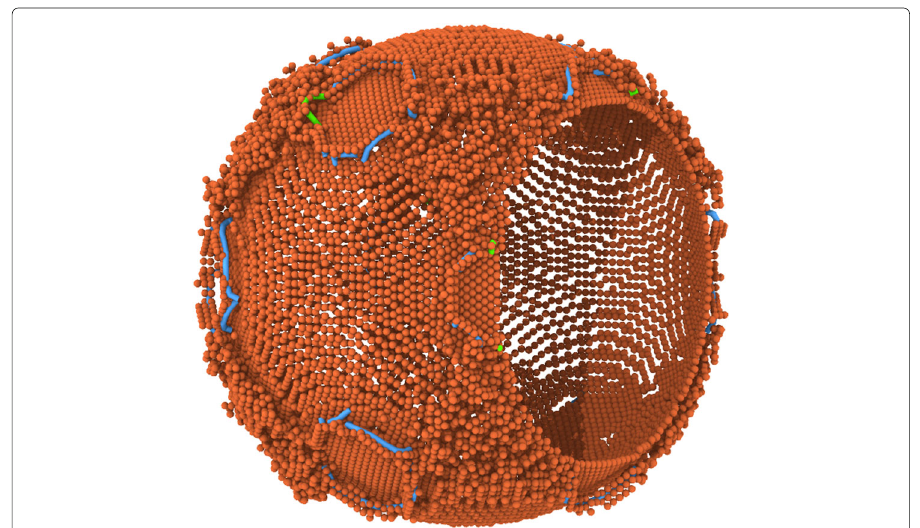
Fig. 5 Relaxed atomic structure of a 15 nm diameter iron cavity with an applied pressure of 10.2 GPa. Only Fe atoms (red spheres) with a coordination number lower than 8 are shown for a better visualization of the cavity external and internal surfaces. A part of the cavity is also cut for sake of clarity. Blue and green tubular lines represent dislocations with (cid:7) 100 (cid:8) and 1 / 2 (cid:7) 111 (cid:8) Burgers vectors, respectively, as determined using the dislocation extraction algorithm (Stukowski et al. 2012) implemented in OVITO (Stukowski